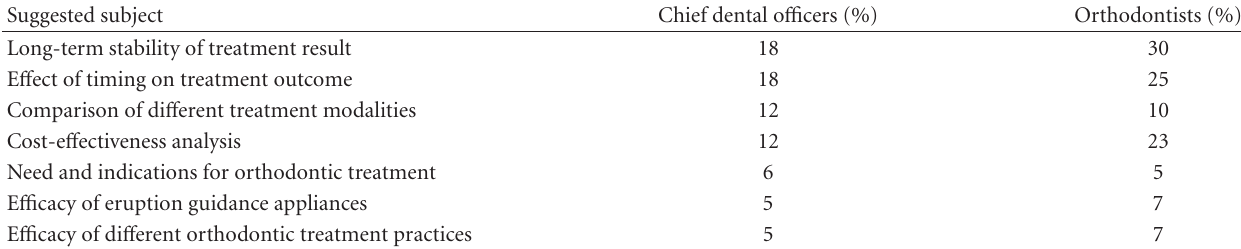
Table 6: Suggestions for subjects for further research in orthodontics (percentage of respondents in parenthesis). Suggested